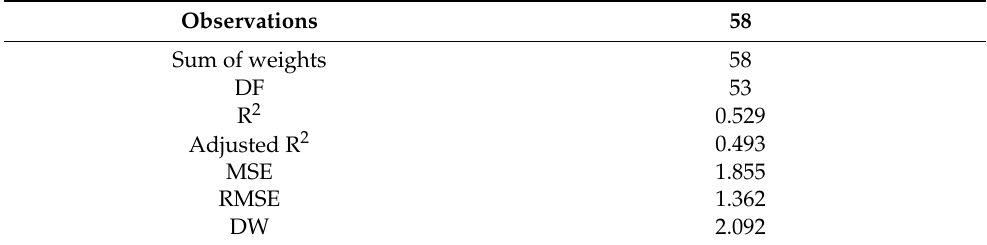
Table 3. Model quality assessment.